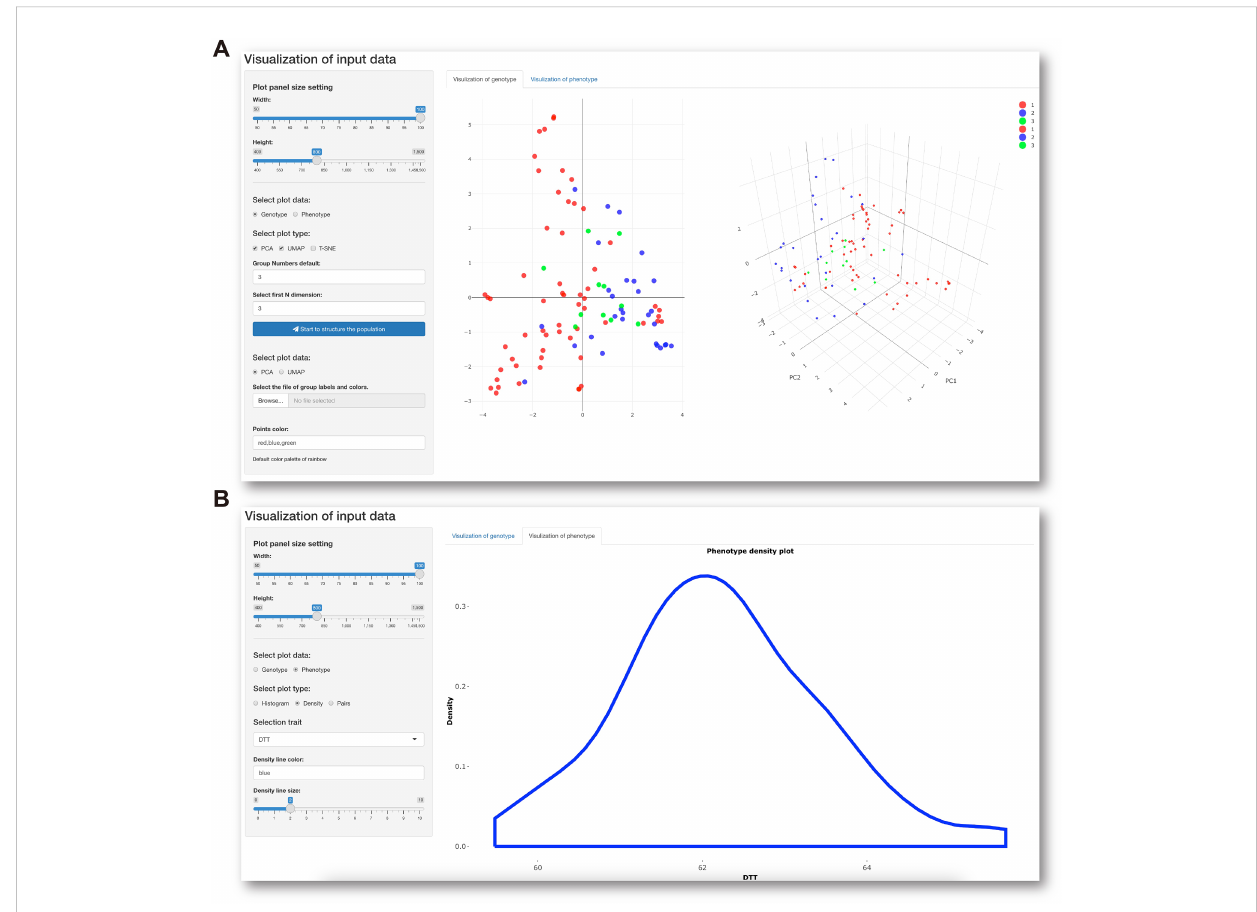
FIGURE 3 Data visualization console. (A) Parameter-setting console (left) for visualization of population structure (right) based on genotypic data. (B) Parameter-setting console (left) for visualization of data distribution (right) of selected phenotypic